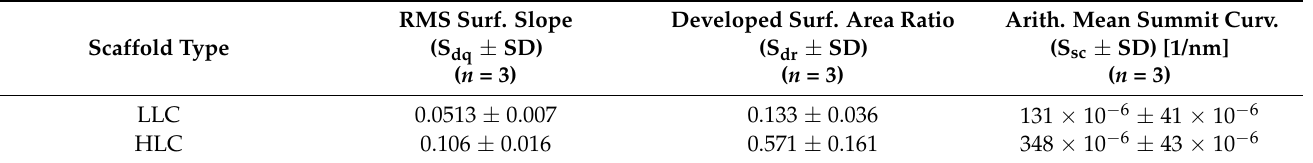
Table 10. Spacing roughness parameters of nanosurface topography: Fastest decay autocorrelation length (Scl37), texture aspect ratio (Str37), and density of summits (Sds).